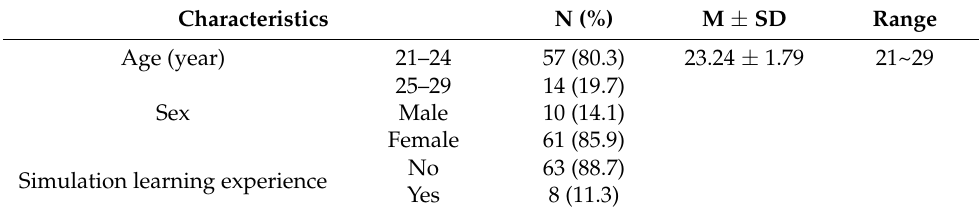
Table 1. Participant characteristics ( n = 71).